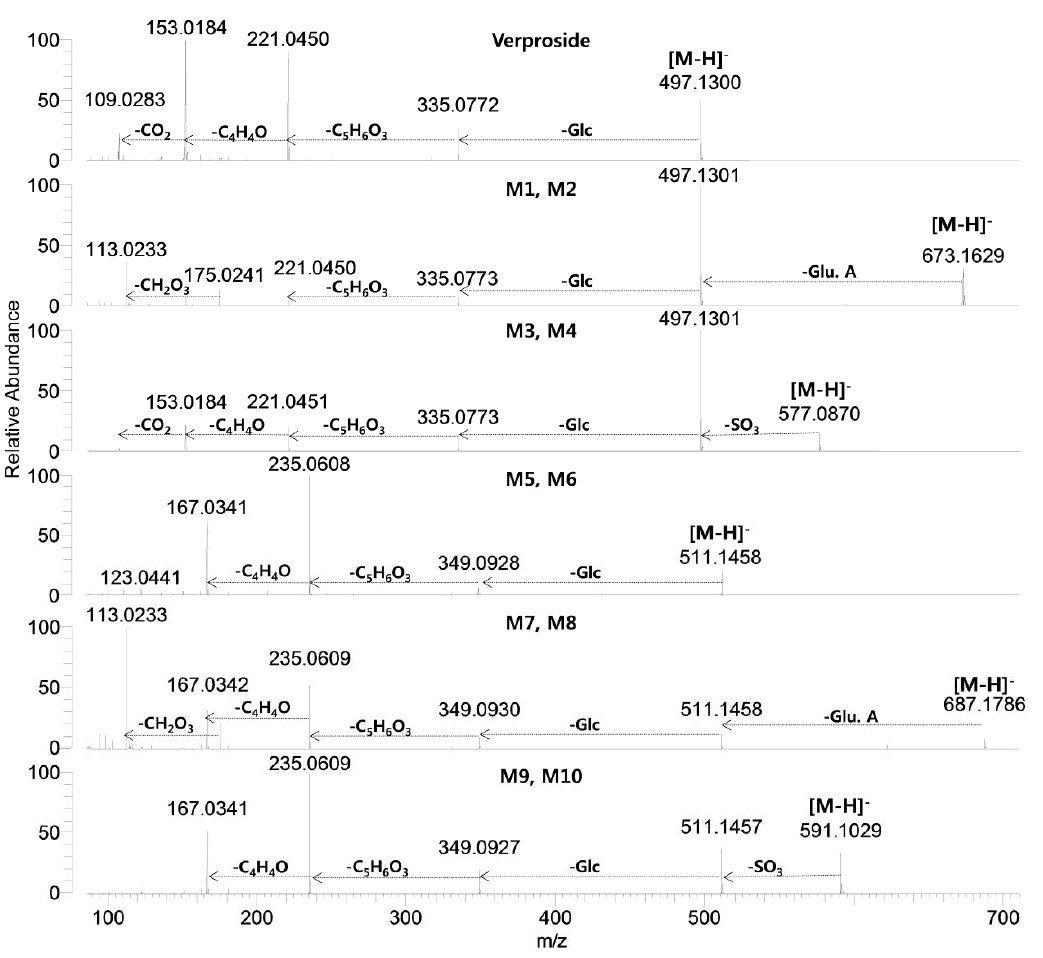
Figure 3. Product scan spectra of verproside and its metabolites (M1–M10) obtained by LC-HRMS analysis of the rat urine and bile samples obtained after intravenous administration of verproside at a dose of 10 mg/kg to a Sprague Dawley rat. Glc: glucose; Glu.A: